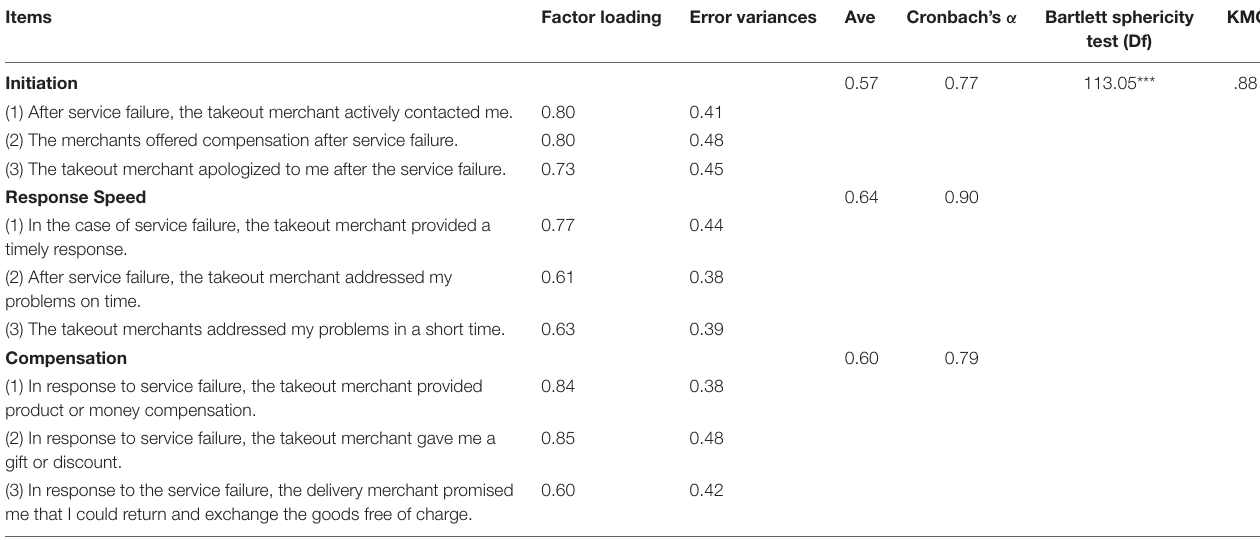
TABLE 2 | Results of the confirmatory factor analysis on service recovery attributes.